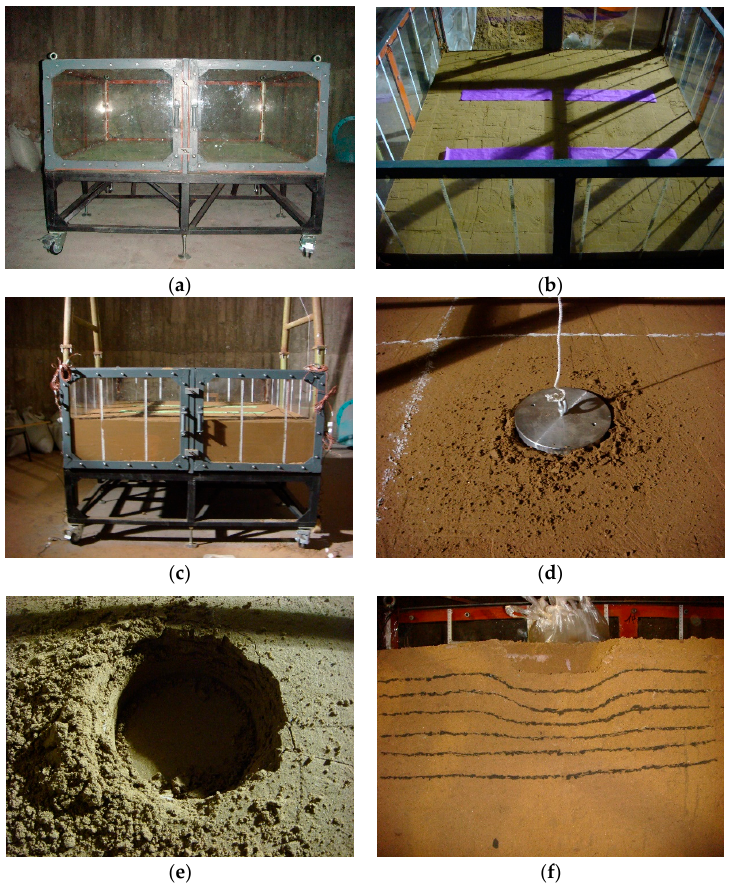
Figure 2. Dynamic compaction test process: ( a ) model preparation, ( b ) soil loading and laying of the colored paper, ( c ) continuing the loading of the soil, ( d ) dynamic compaction test, ( e ) end of the test, and ( f ) determination of the settlement of each layer after the dynamic compaction test.